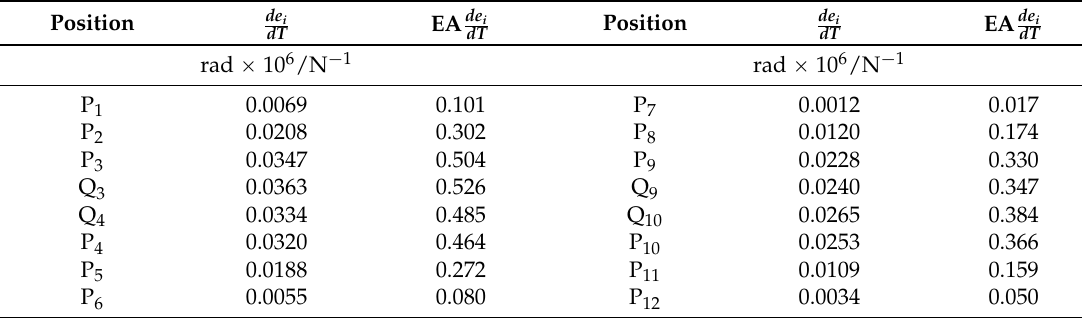
Figure 18. Strain gauges location and equilibrium scheme (unit length: mm). Table 9. Strain and axial force gradients—joint sample “I”.